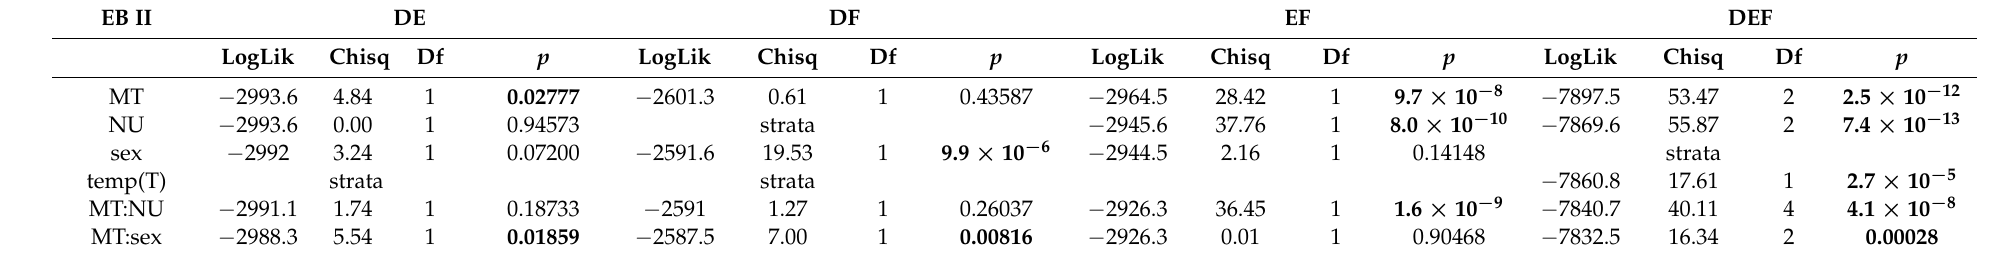
Table 3. The effect of mitochondrial haplotype (MT), nuclear genetic background (NU), sex, temperature (T) and their interactions on desiccation resistance for the experimental block (EB) II of D. obscura . LogLik, log-likelihood; Chisq, chi-squared value; Df, degrees of freedom; strata, variable is stratified; p values that are significant at p < 0.05 are given in